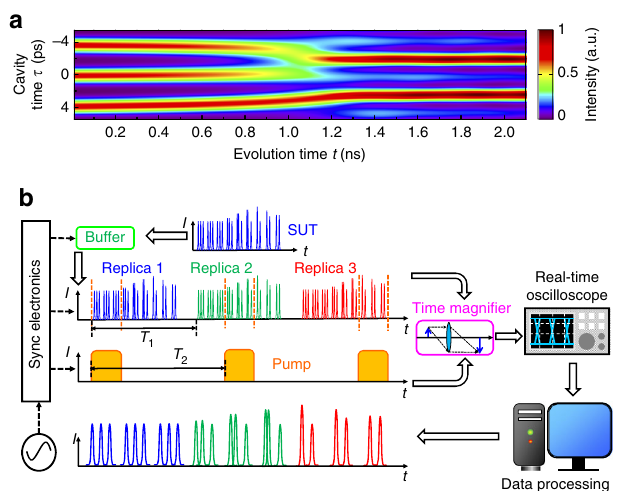
Fig. 1 Working principle of the PARTI system. a Slowly evolved dissipative Kerr soliton dynamics in an ultrahigh- Q microresonator, obtained by numerically solving the Lugiato – Lefever equation. The orders-of-magnitude difference in the timescale between the cavity time and the evolution time poses an experimental challenge to capture the comprehensive picture of the dynamics. b The schematic representation of the PARTI system. The optical buffer generates multiple replicas (represented by blue, green and red , respectively) of the SUT and the subsequent time magni fi er captures different portions of the SUT waveform on each replica. After data processing on the system output, the original long SUT waveform can be reconstructed through waveform